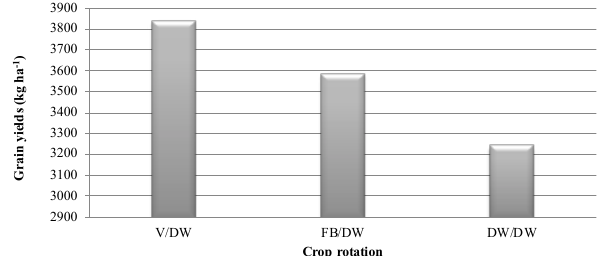
Figure 10. Correlation between Fusarium culmorum incidence (%) on wheat stem bases and grain yields (kg ha -1 ) of durum wheat har- vested from three demonstration trials at Fernana, Tunisia.